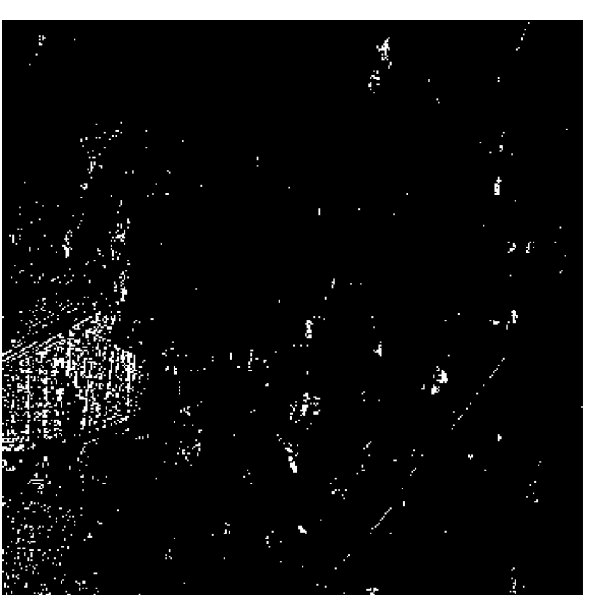
Figure 4. First region’s result